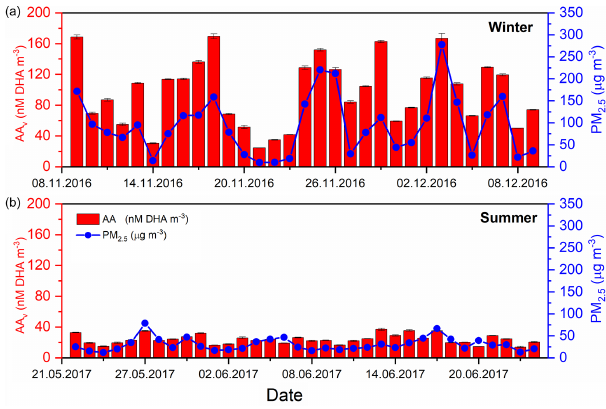
Figure 1. Time-averaged (24h) volume-normalised AA v (red bars) and PM 2 . 5 mass (blue dots), analysed from 24h high-volume filters, for both winter 2016 (8 November–8 December 2016) and summer 2017 (21 May–24 June 2017) (Shi et al., 2019; Xu et al., 2020a). Substantially higher average PM 2 . 5 mass concentrations (µgm − 3 ) and AA v were observed in the winter season compared to the sum- mer (see Table S1 for summary). DCFH v , DTT v and EPR v 24h averaged datasets can be found in Figs. S8–S10